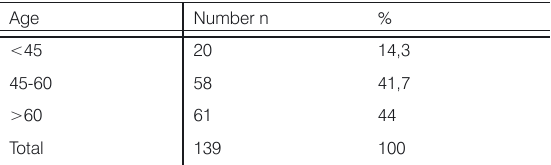
Table 1. Age of endometrial cancer patients.